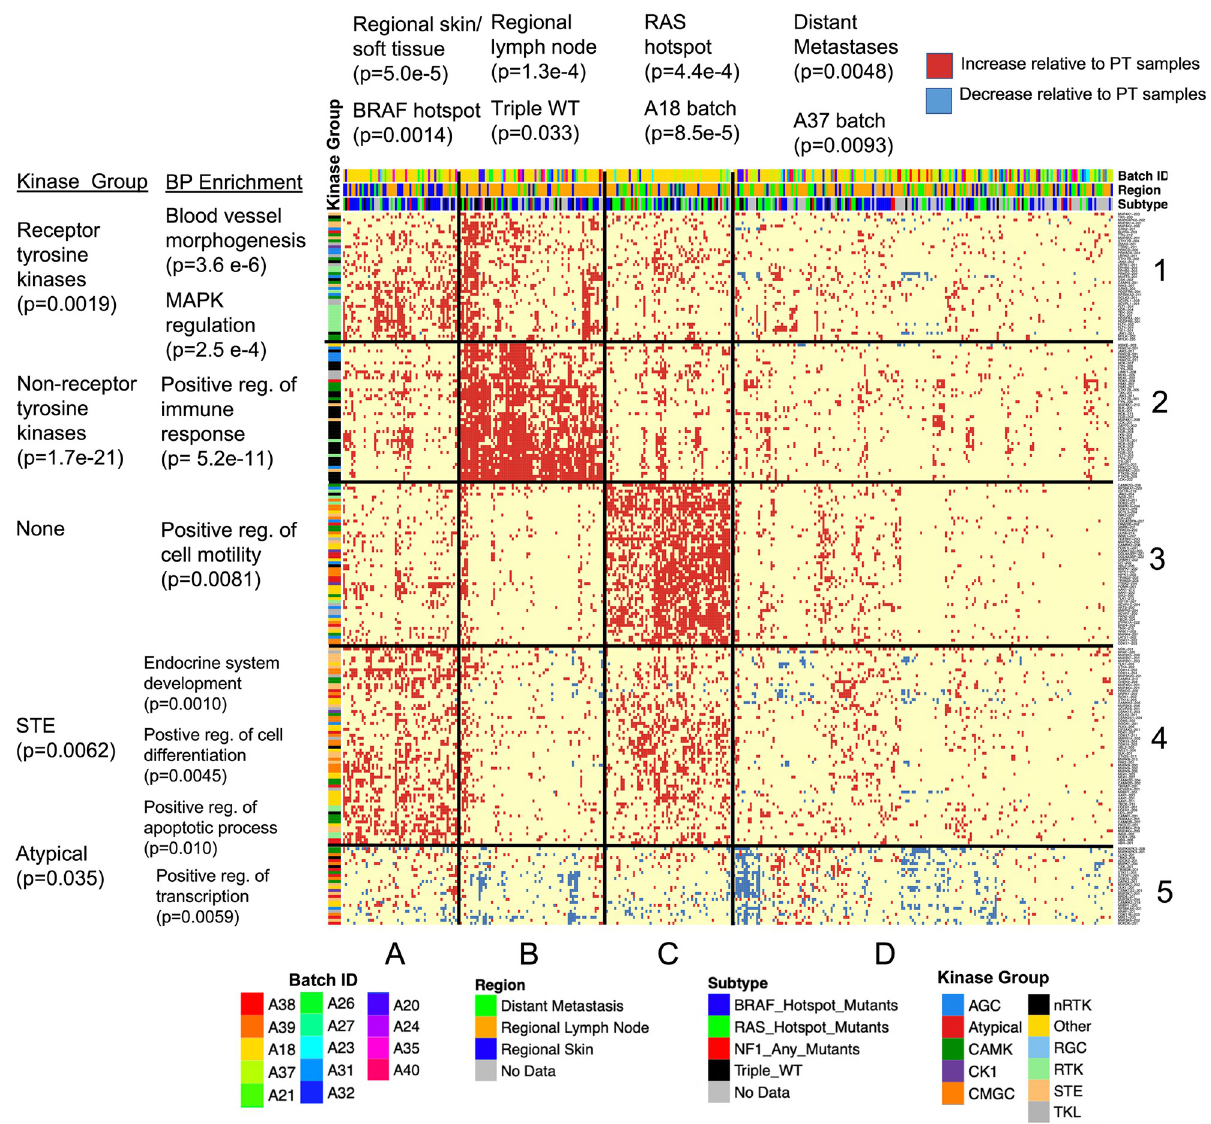
Fig 8. Heatmap of 367 metastatic samples clustered according to kinase isoform counts. Red dots indicate increased expression in metastases (Quasi-Poisson GLM, p < 0.05) while blue dots indicate decreased expression (p < 0.2). Shown are the 367 metastatic samples (columns) and 235 isoforms that were altered in > 13% of samples (rows). P-values for enrichments were calculated using the one-sided Fisher’s exact test.